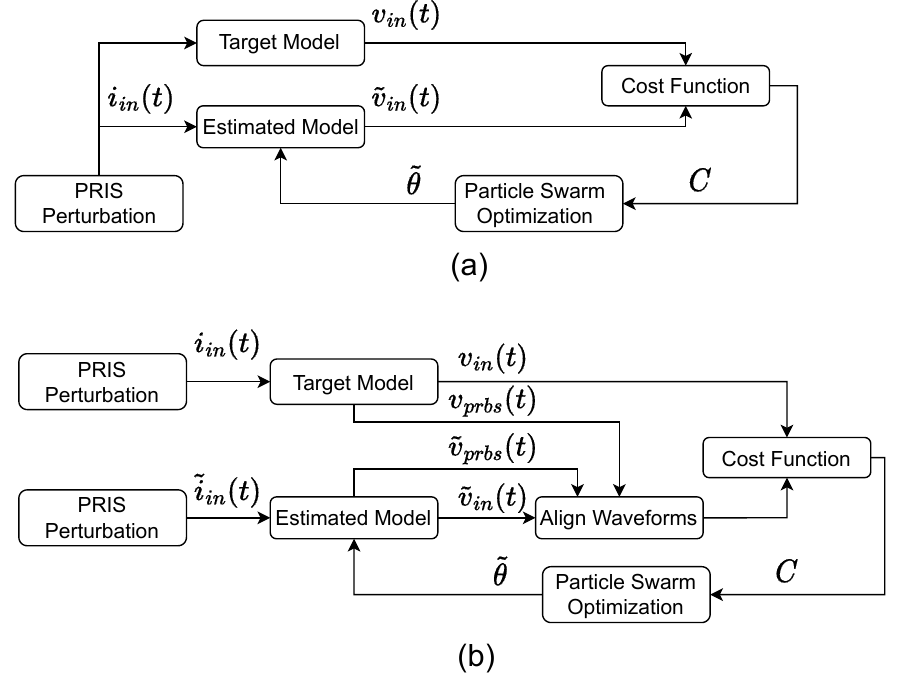
Figure 4. Classical Time-domain Parameter Estimation Methodology: ( a ) Alignment Strategy 1 and ( b ) Alignment Strategy